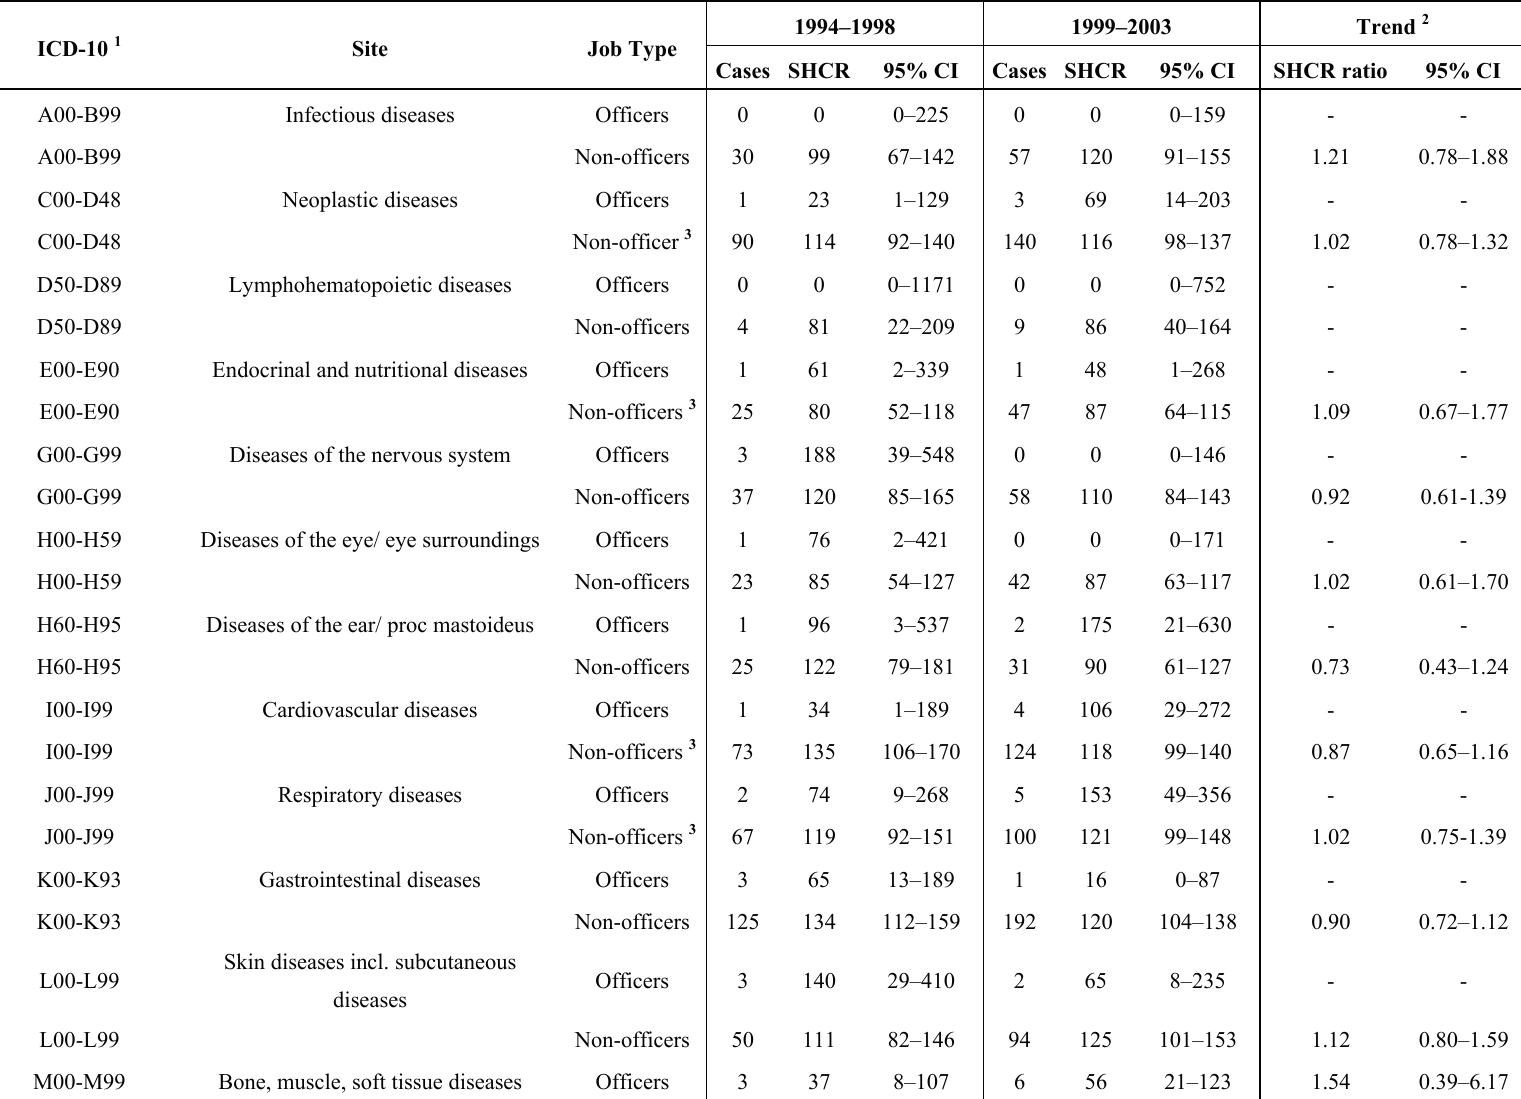
Table 3. Standardized hospital contact ratios (SHCR) 1994–2003 among Danish seamen by job type and time period (women) 2